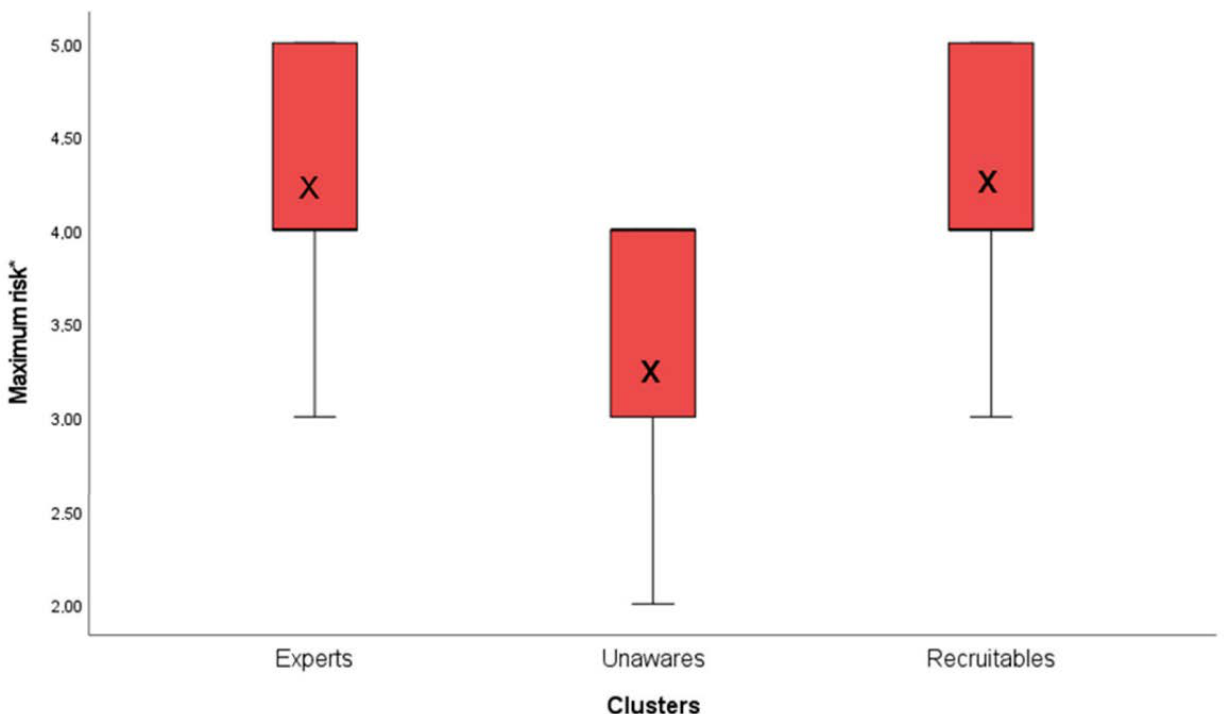
Figure 3. Boxplots of the variables associated with patients’ safety (the credible maximum risk of omitted hand disinfection) across all three clusters. Note: Maximum risk*—The item measures pa- tients’ safety according to international standards of ISO 31000 of medical failure mode effect anal- ysis (FMEA): “The maximum credible effect of omitted hand hygiene is: without consequence (1), minor—without any long-lasting effect (2), severe—with a prolonged hospital stay (3), critical— with long-lasting effects (4), and lethal (5)”; X—the mean value of the variable in the cluster. The one-way ANOVA determined the statistically significant difference between groups. Eta-squared showed 0.11 as the medium effect size. The Bonferroni post-hoc contrasts revealed that the maxi- mum credible effect of omitted hand hygiene was estimated to be statistically significantly higher by the members of the first and third clusters in comparison to the second cluster.